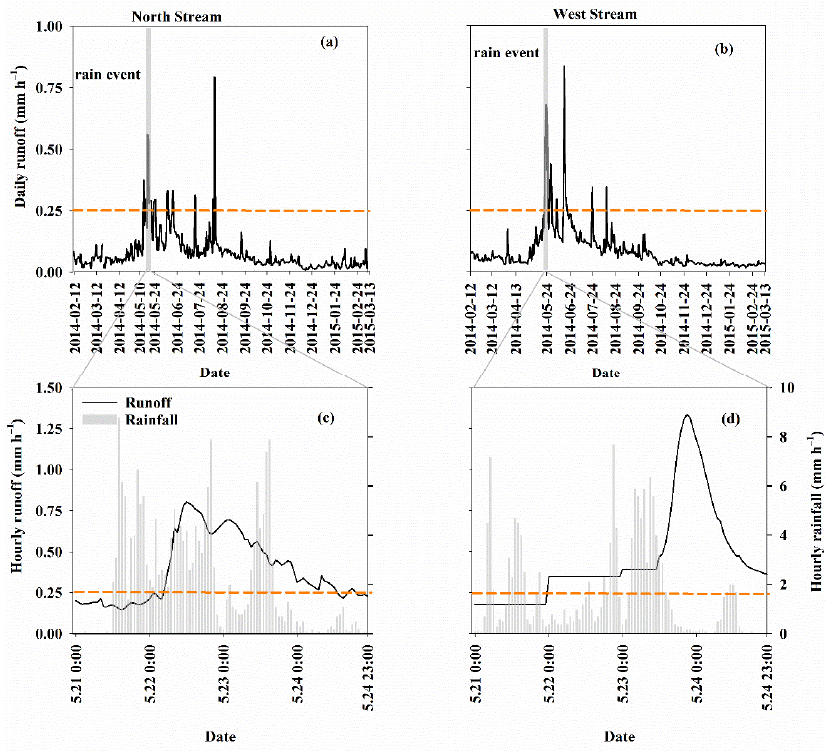
Figure 2. The daily average runoff in the NS ( a ) and the WS ( b ) during the investigation period. The hourly runoff in the NS ( c ) and the WS ( d ) during the rain event. The dashed orange lines represent Q/Q m = 3.